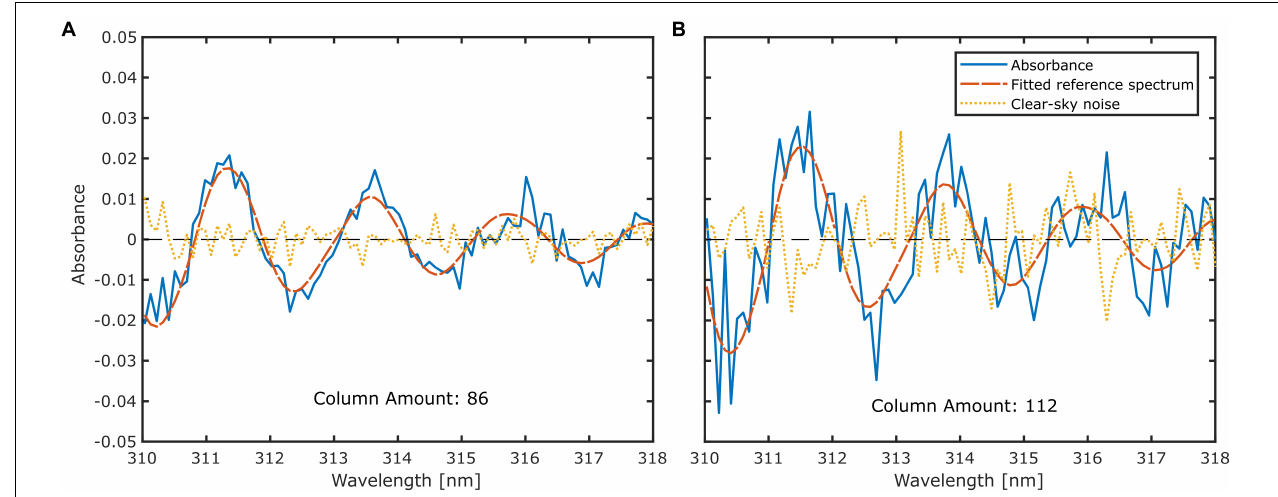
FIGURE 6 | Relatively low column density DOAS fits for (A) traverse and (B) scan modes on Masaya volcano. Also shown are noise spectra generated using a second clear-sky spectrum as I ( λ ) , as opposed to an in-plume spectrum (see Equation 1). Differences in noise levels results from different viewing geometries and conditions for the traverse and scan